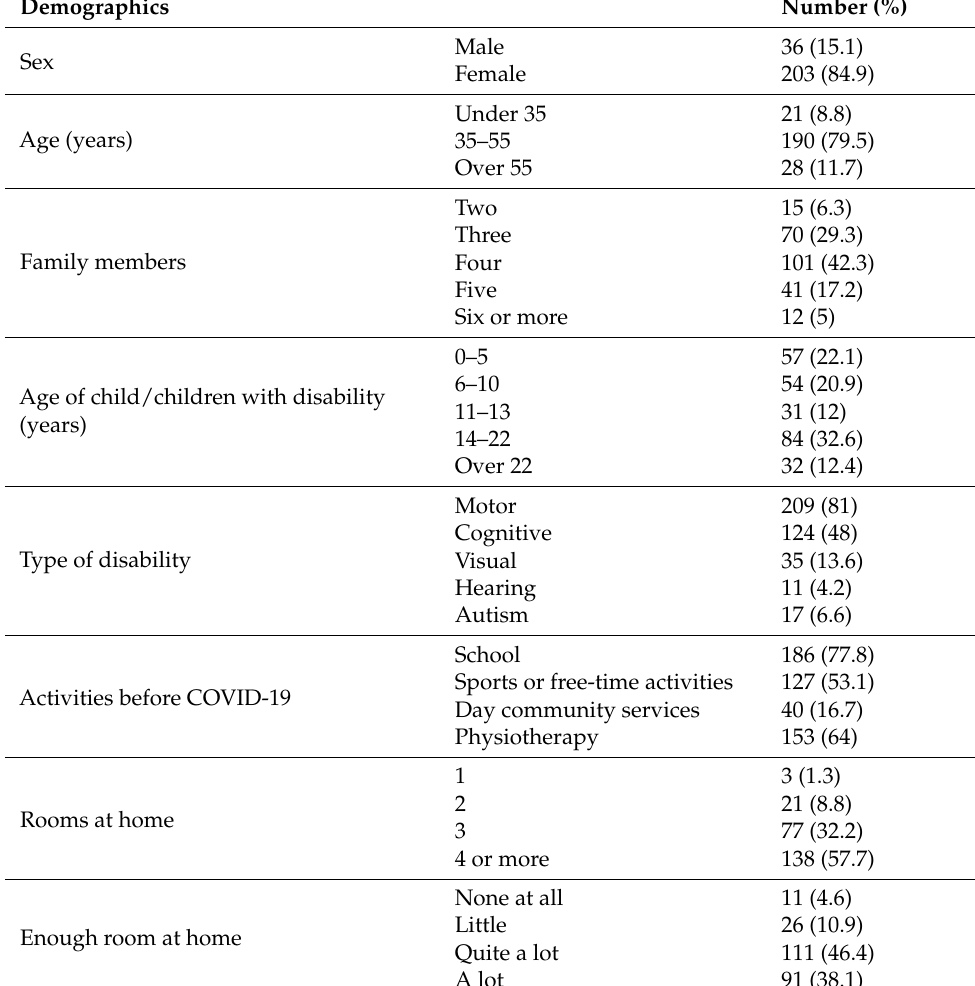
Table 1. Parents’ demographic information ( n = 239).